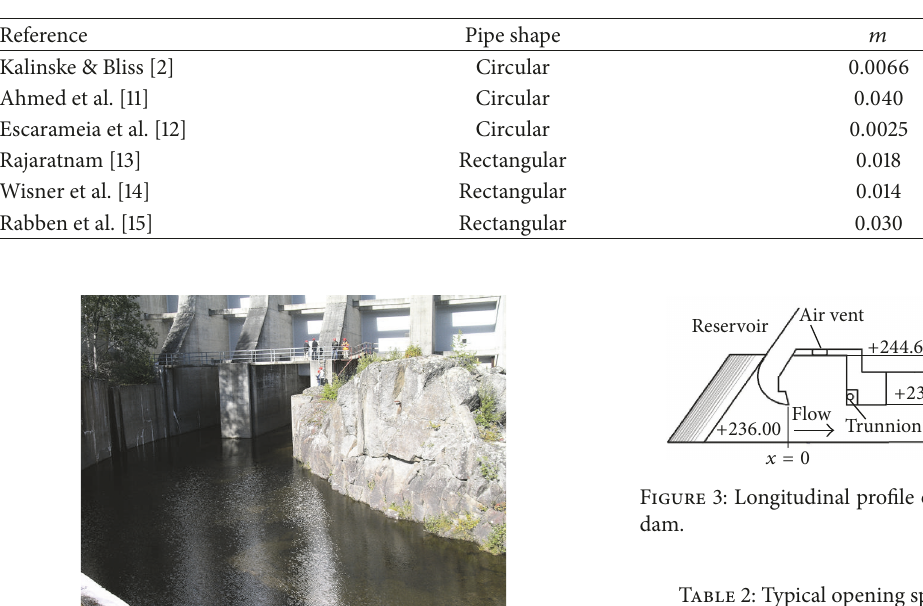
Table 1: Air entrainment formulas for steady hydraulic jump.